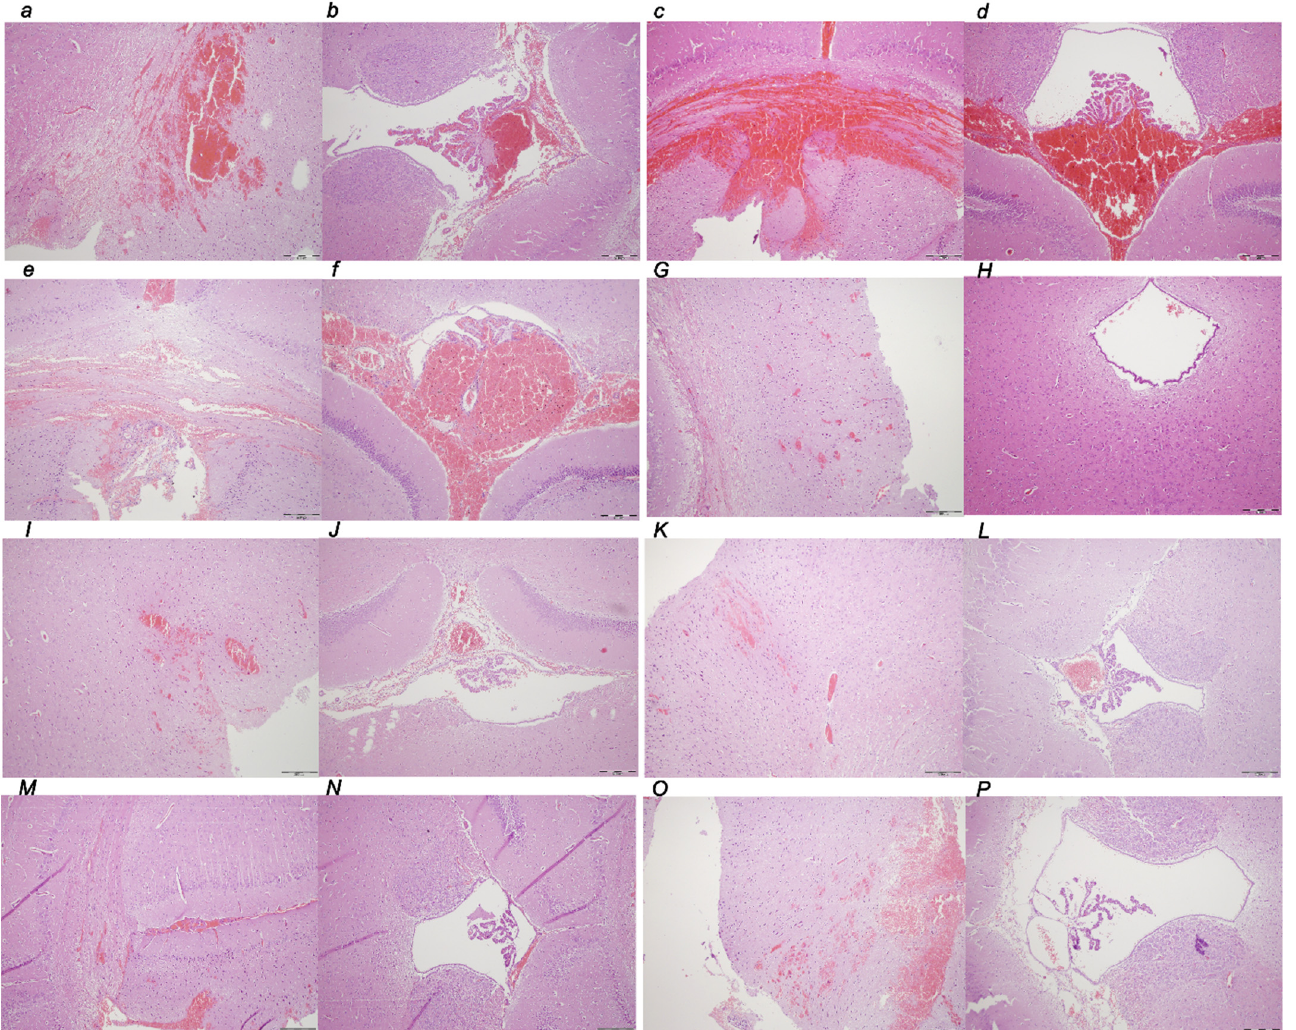
Figure 15. Brain hemorrhage lesion illustrative microscopic presentation in rats with obstructed bile duct ( a – P ) at the end of the ligation time periods of 30 min, 5 h, and 24 h; as an early regimen at 0–30 min ( a , b , G , H ), 0–5 h ( c , d , I , J ), and 0–24 h ( e , f , K , L ) application sacrifice period; and as delayed regimen at 4.30 h–5 h ( M , N ) and 5 h–24 h ( O , P ) application sacrifice period in controls ( a – f ) and BPC 157-treated rats ( G – P ). Control ( a – f ); ( a , b ) (0–30 min); ( c , d ) (0–5 h); ( e , f ) (0–24 h). BPC 157 regimens ( G – P ). Early regimens ( G – L ); ( G , H ) (0–30 min); ( I , J ) (0–5 h); ( K , L ) (0–24 h). Delayed regimens ( M – P ); ( M , N ) (4.30 h–5 h); ( O , P ) (5 h–24 h). (HE staining, magnification 100×; scale bar 200 µ m). Control group. ( a , c , e ). Large areas of intracerebral hemorrhage in the corpus callosum, amygdala, and neocortex. ( b , d , f ). Intraventricular hemorrhage in the 3rd ventricle; BPC 157 group. ( G , I , K , M , O ). Minor intracerebral hemorrhage of the corpus callosum and neocortex. ( H , J , L , N , P ). No hemorrhage in the 3rd ventricle.